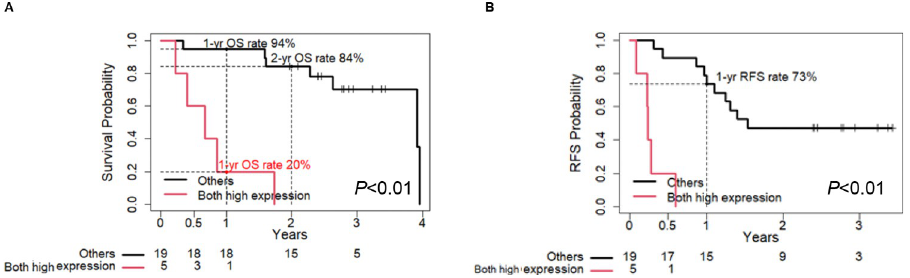
Fig 5. Correlation between the combination of PODXL with ITGB1 and poor outcomes of PDAC patients. (A, B) Kaplan-Meier analysis of (A) OS and (B) RFS rates according to the combination of PODXL with ITGB1.